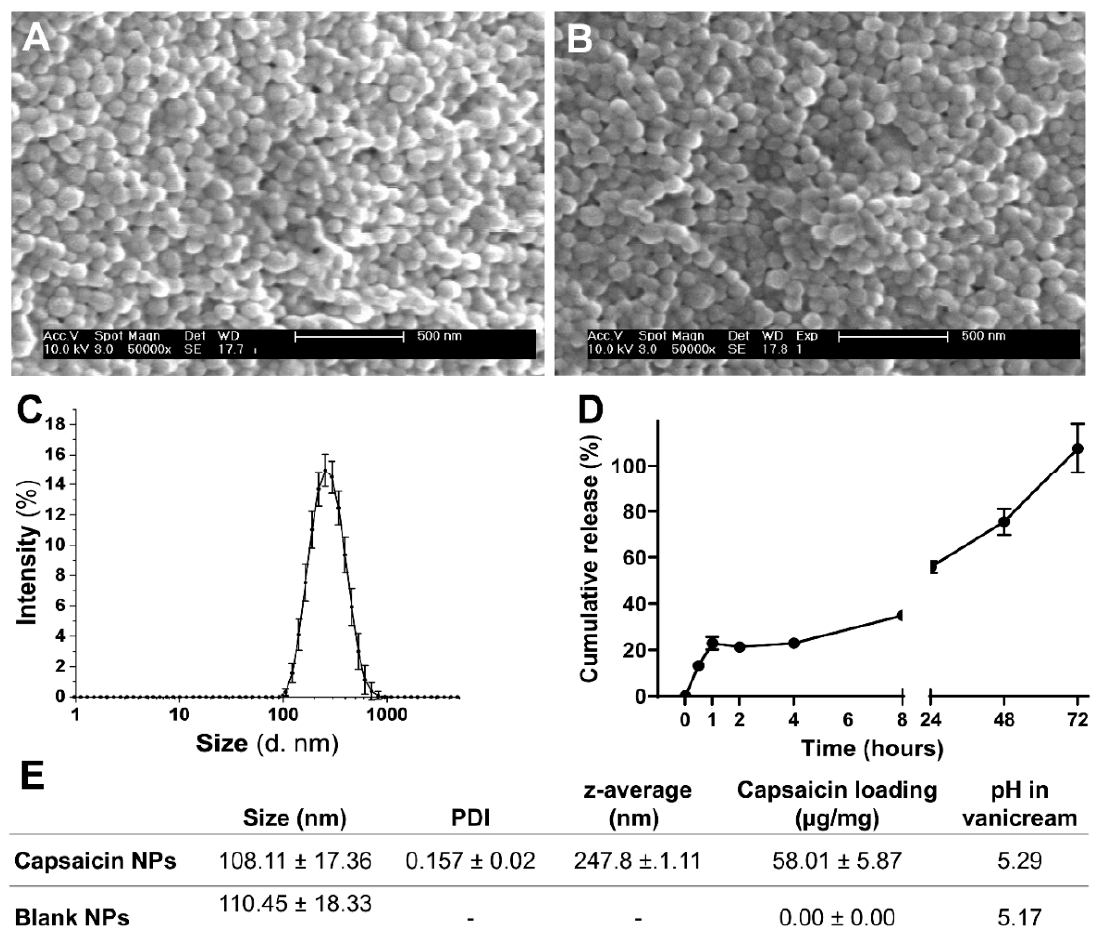
Figure 1. Characterization of the physicochemical attributes of NPs. ( A ) SEM of capsaicin NPs. ( B ) SEM of blank NPs. Scale bar is 500 nm. ( C ) Intensity-based particle size distribution as measured by dynamic light scattering. ( D ) Cumulative in vitro release of capsaicin from NPs over time under agitation. ( E ) Measurements of size, capsaicin loading, encapsulation efficiency and pH (in Vanicream) for capsaicin-loaded and blank NPs. Mean ± SEM.